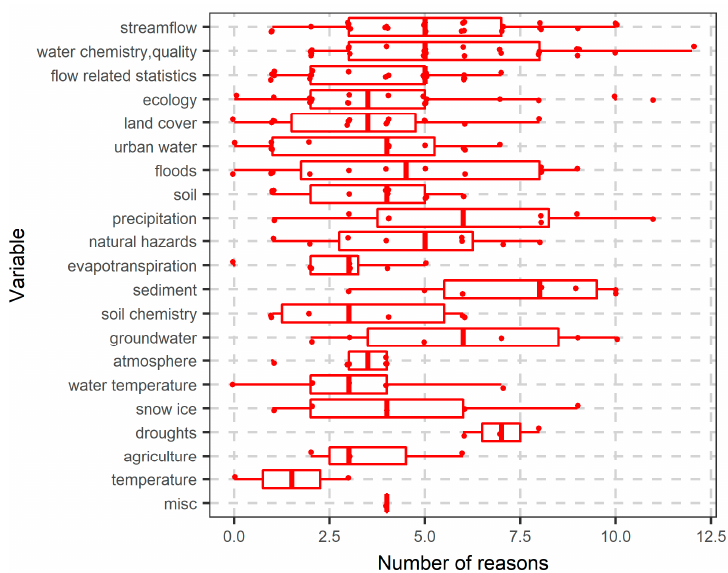
Figure 13. Boxplot of number of reported reasons for using random forests conditioned on the examined variable. The variables are ranked in descending order based on the number of papers implementing random forests (see Figure 7).